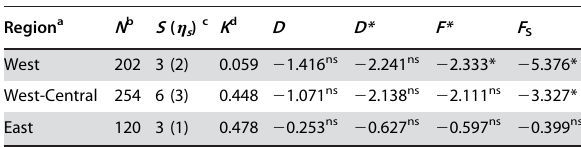
a West: Nigeria, Benin, Ghana, Ivory Coast, Burkina Faso, Mali and Senegal. West- Central: Angola, Gabon, Equatorial Guinea (including Bioko island) and Cameroon. East: Tanzania, Kenya, Malawi and Mozambique. b Sample size (n u of chromosomes). c Number of segregating sites, S , and number of singleton mutations ( g d Average number of pairwise nucleotide differences. Neutrality tests: Tajima’s